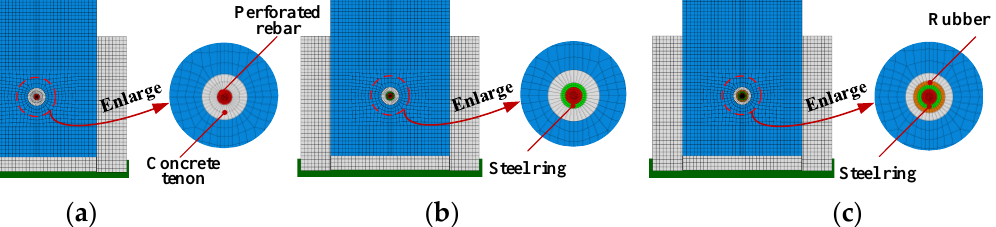
Figure 8. Cutaway of three different types of shear connector models: ( a ) concrete tenon, ( b ) steel ring tenon, ( c ) steel – rubber tenon.